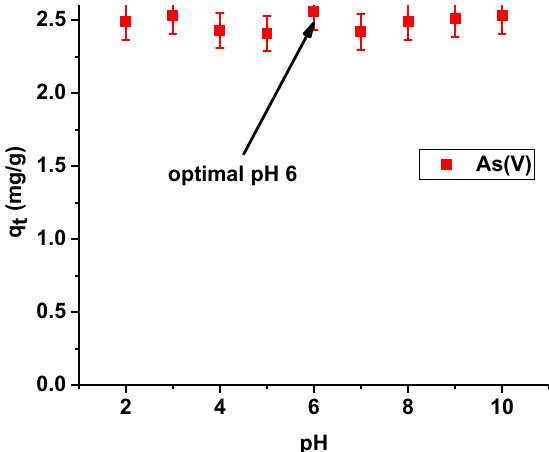
Figure 10. E ff ect of pH on adsorption of arsenic(V) on X np -La(III) (c 0 = 10 mg / L; m = 0.1 g; t = 24 h, T = 295 K, shaking speed 180 Figure 10. Effect of pH on adsorption of arsenic(V) on X np -La(III) (c 0 = 10 mg/L; m = 0.1 g; t = 24 h, T = 295 K, shaking speed 180 rpm).